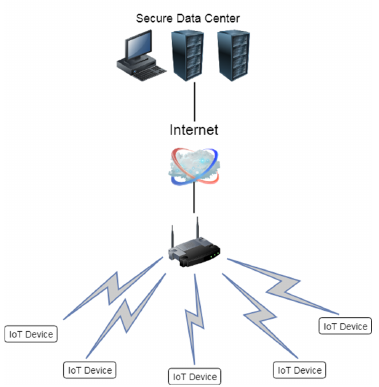
Figure 3. Internet of Things (IoT) system model. Table 1. Algorithm botation description.